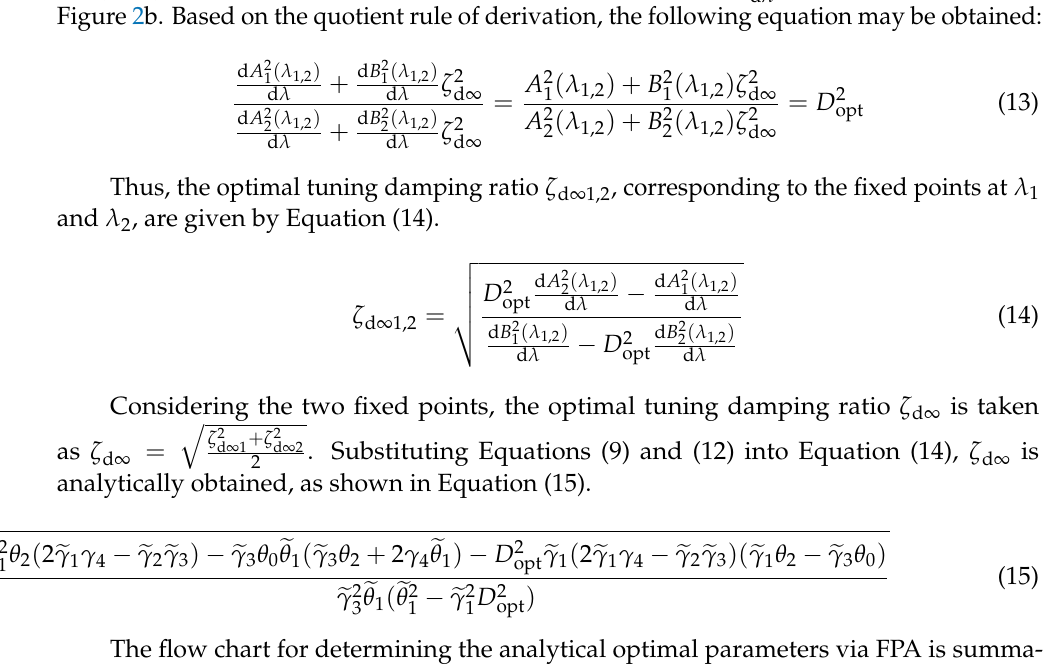
The flow chart for determining the analytical optimal parameters via FPA is summa- rized in Figure 3. Based on the procedure, the analytical solutions to the optimal